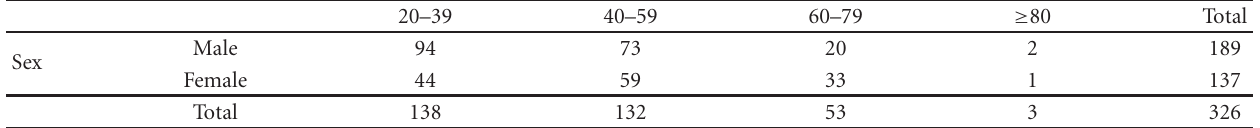
Table 1: Sex versus age groups of iloye screening